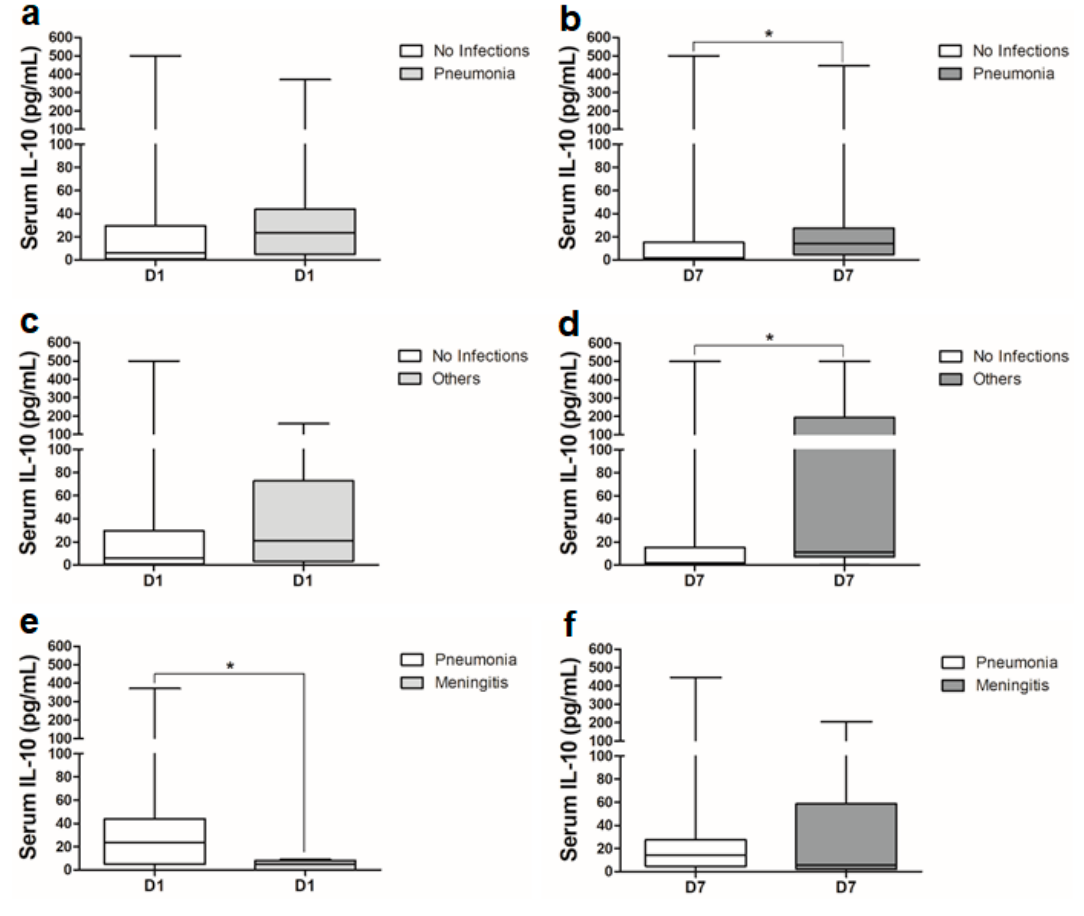
Figure 4. Comparison of serum IL-10 levels between SAH patients with: ( a ) no infections ( n = 49) and pneumonia ( n = 15) on day 1; ( b ) no infections ( n = 49) and pneumonia ( n = 15) on day 7; ( c ) no infections ( n = 49) and others ( n = 6) on day 1; ( d ) no infections ( n = 49) and others ( n = 6) on day 7; ( e ) pneumonia ( n = 15) and meningitis ( n = 6) on day 1; ( f ) pneumonia ( n = 15) and meningitis ( n = 6) on day 7. Mann–Whitney U test; p < 0.05 is significant (* p < 0.05).